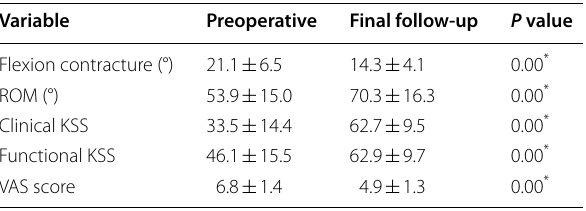
Table 2 Comparison of function and pain preoperatively and at the final